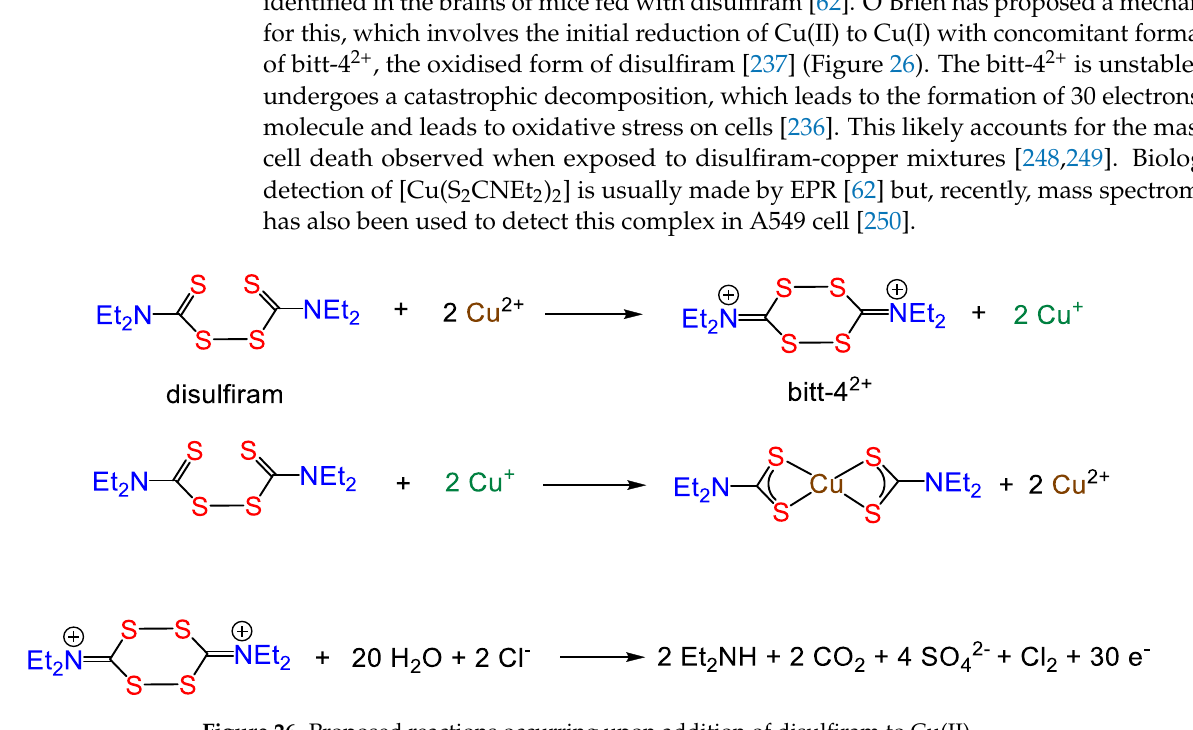
Figure 26. Proposed reactions occurring upon addition of disulfiram to Cu(II). [Cu(S 2 CNEt 2 ) 2 ] is also an effective anticancer [236,248,251–256] especially in vitro as are many derivatives [36,37,257–262]. This was first established for pyrrolidine dithiocar- bamate, which exhibits high potency to inhibit a cancer-specific proteasome, showing a cytotoxic effect on different human tumour cells after complexation with copper. Generated [Cu(S 2 CNC 4 H 8 ) 2 ] has also been reported to induce cellular apoptosis in both prostate and human breast cancer cells [257,263] and is a potential treatment for refractory neurob- lastoma in children. Zhang et al. [264] have reported suppression of the proliferation of BE(2)C cells (a human neuroblastoma cell line) using this complex, having a higher potency than cisplatin based on IC 50 values. The treatment of cancer cells resulted in an arrest of cell cycle progression and cellular apoptosis. Investigation of a series of substituted pyrrolidine complexes has allowed a structure–activity association [265,266]. Thus, both the ligand polarity and ring size affect the activity, with the proteasome-inhibitory abil- ity being significantly decreased upon ring substitution by large and polar groups [266]. Furthermore, Wang et al. have reported that some pyrrolidine derivatives exhibited less inhibition activity of aldehyde dehydrogenase (ALDH) in human breast cancer cells [265]. The activity of [Cu(S 2 CNEt 2 ) 2 ] against osteosarcoma cancer lines has been measured, showing IC 50 values of 2.37 ± 0.12 µ M after 24 h, while analogous Fe(III) and Cr(III) complexes were inactive and Mn(III) had higher IC 50 values of 13.3 ± 1.43 µ M [262]. Higher levels of ubiquitin-bound proteins were observed by cells treated with [Cu(S 2 CNEt 2 ) 2 ] and the accumulation of proteasome substrate IkB α . Apoptosis of the cancer cell was observed to proceed by the activation of caspases 3 and 7, which resulted in cleavage of PARP-1 into smaller fragments. The anticancer activity of copper dithiocarbamate complexes can be tuned by varying substituents tuning both structural and electronic properties. This was observed in the study on the antiproliferative activity of two copper complexes of dithiocarbamate glycoconjugates (glucose and galactose) on human cancer cell lines [267]. A four-fold increase in activity was observed as compared to the free ligands. Their activity was also influenced by the nature of the glycoconjugates, with the galactose-based complex showing higher antiproliferation activity as compared to